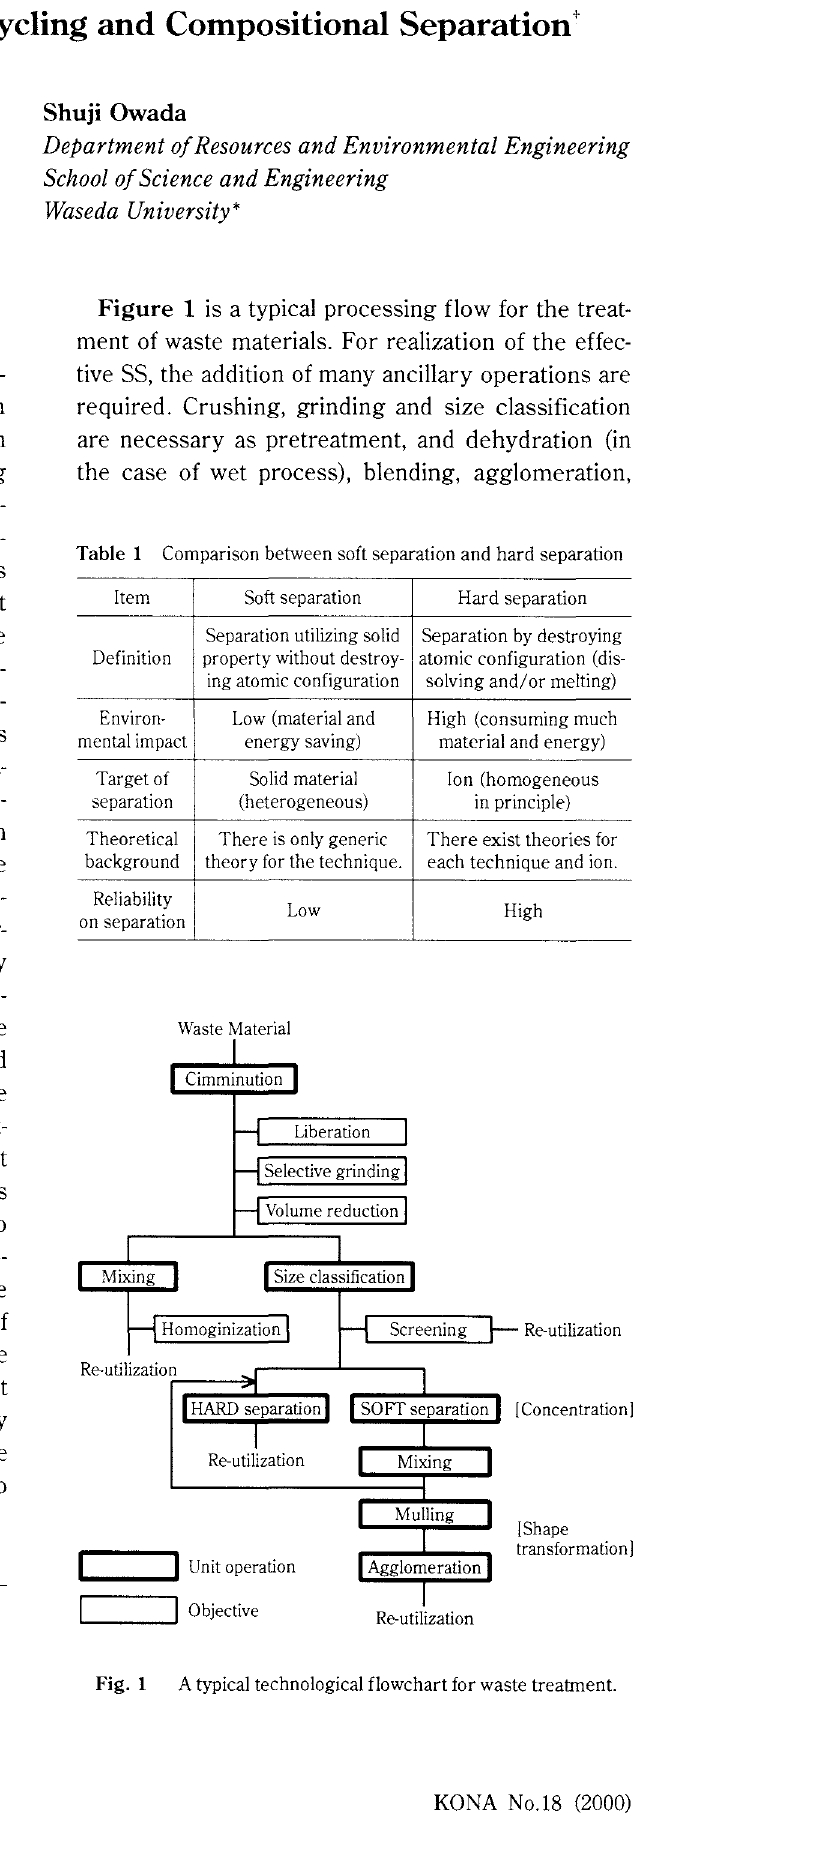
A typical technological flowchart for waste